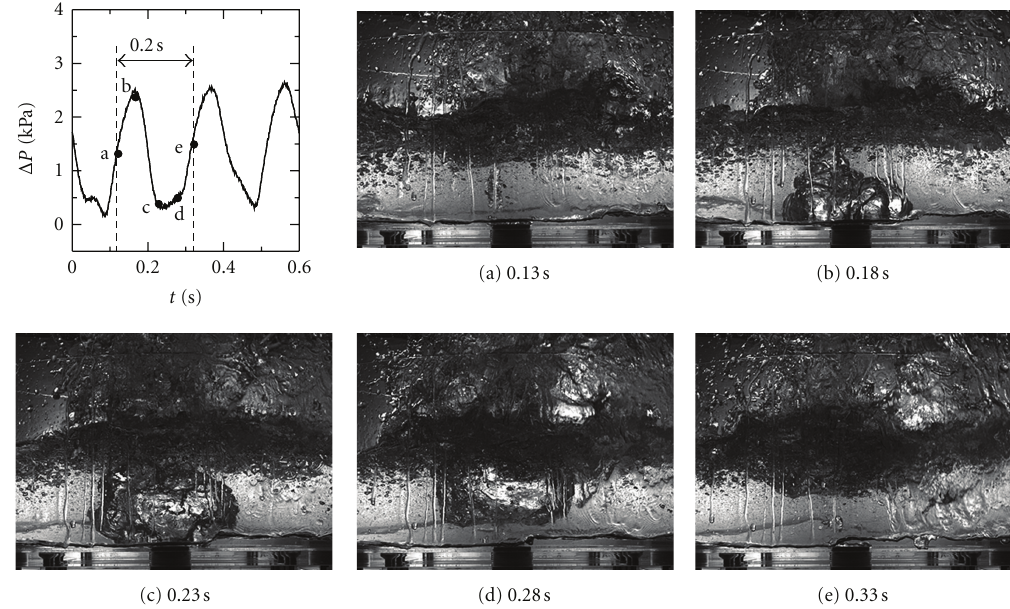
Figure 7: Bubble generation process in the cylindrical tank (a) ( J G = 4 . 9 m/s, J G ∗ 1 / 2 = 0 . 50, Ku G 1 / 2 = 1 . 0, and D = 45mm).